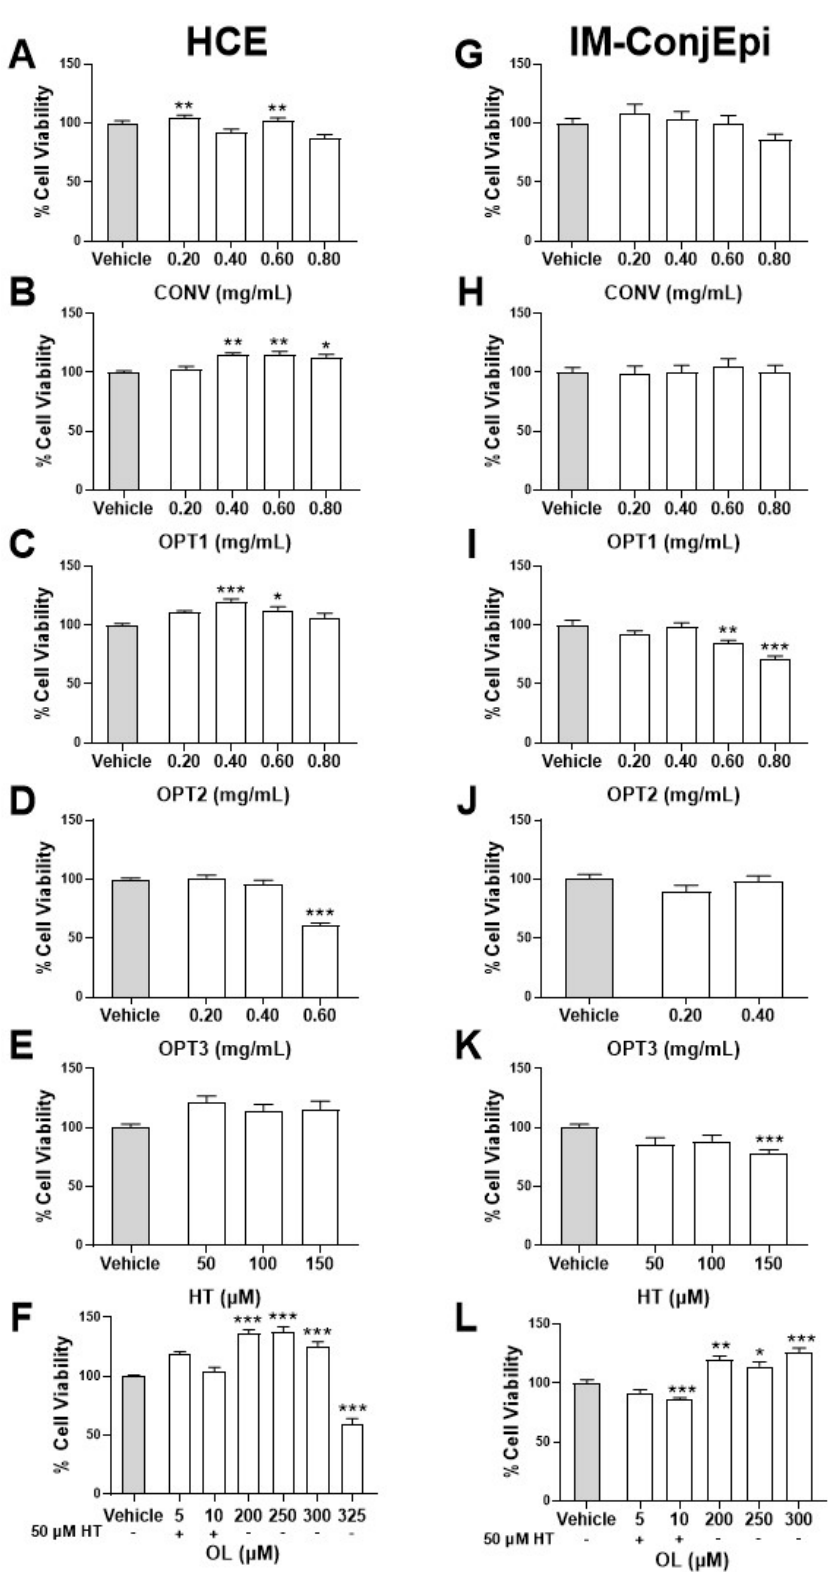
Figure 1. Cell viability assays of Hydroxytyrosol (HT), Oleuropein (OL), and their combination, together with the conventional (CONV) and the three optimized (OPT1, OPT2, and OPT3) olive pomace (OP) extracts on HCE ( A – F ) and IM-ConjEpi ( G – L ) cells. Cells were treated for 24 h with HT (50, 100, and 150 μ M), OL (200, 250, and 300 μ M for both cells lines, and 325 μ M for HCE), OL + HT (5 μ M of OL + 50 μ M of HT and 10 μ M of OL + 50 μ M of HT), CONV (0.20, 0.40, 0.60, and 0.80 mg/mL), OPT1 (0.20, 0.40, 0.60, and 0.80 mg/mL), OPT2 (0.20, 0.40, 0.60, and 0.80 mg/mL), OPT3 (0.20 and 0.40 mg/mL for both cell lines, and 0.60 mg/mL for HCE), or vehicle (cell culture medium for HT and OL or 0.4% ethanol for the extracts). The in vitro toxicity was performed using the XTT assay. For CONV and OPT1, none of the concentrations tested were considered toxic, neither for HCE ( A , B , respectively) nor for IM-ConjEpi ( G , H , respectively). OPT2 is nontoxic up to 0.80 mg/mL for HCE ( C ) and 0.40 mg/mL for IM-ConjEpi ( I ), whereas up to 0.40 mg/mL of OPT3 is nontoxic for both cell lines ( D , J ). For HT, only 150 μ M decreased cell viability on IM-ConjEpi ( K ), while all con- centrations were safe for HCE ( E ). For OL, only 325 μ M was considered toxic for HCE ( F ), while all concentrations tested on IM-ConjEpi were considered nontoxic ( L ). For the OL + HT mixture, 10 μ M OL + 50 μ M HT was toxic for IM-ConjEpi ( L ), while both mixtures were safe for HCE ( F ). Data are